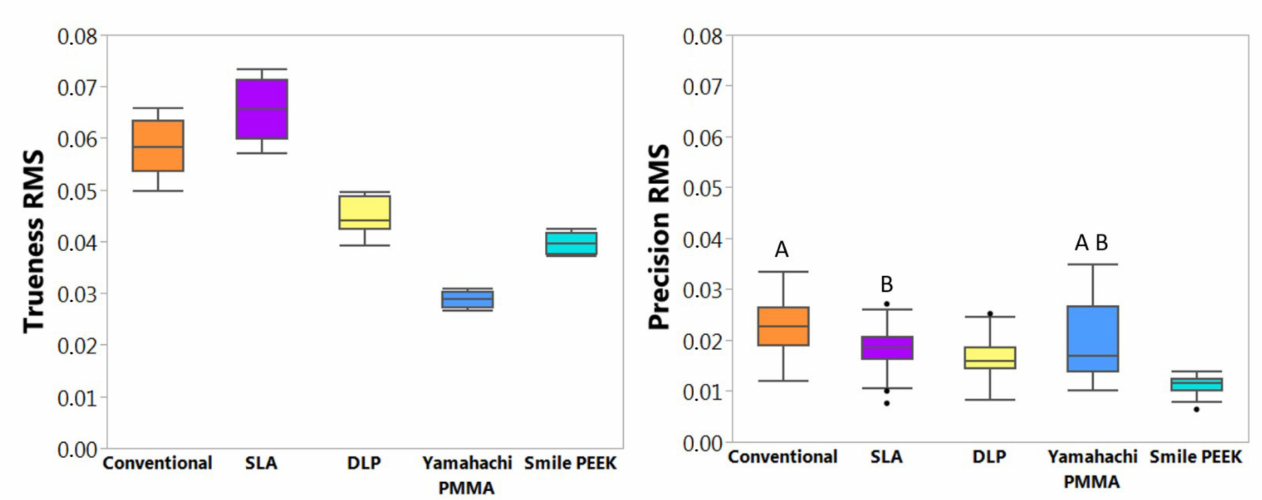
Figure 6. Mean trueness and precision root mean square (RMS) values ( n = 12) for all groups. Trueness: normally distributed. Groups compared by all pairs Tukey–Kramer HSD analysis, all groups being significantly different ( p < 0.05). Precision: non-normally distributed. Groups were compared by the Wilcoxon method ( p < 0.05) and statistically comparable groups are denoted by letters. Lower RMS values correspond to higher trueness and precision